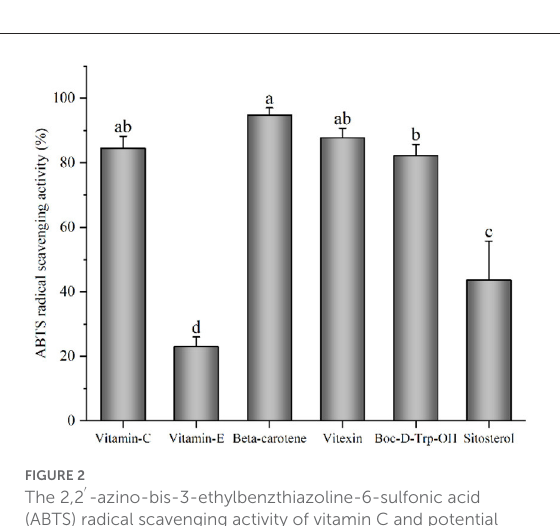
FIGURE2 The 2,2 ′ -azino-bis-3-ethylbenzthiazoline-6-sulfonic acid (ABTS) radical scavenging activity of vitamin C and potential bioactive compounds (means that do not share a letter were significantly different, p <